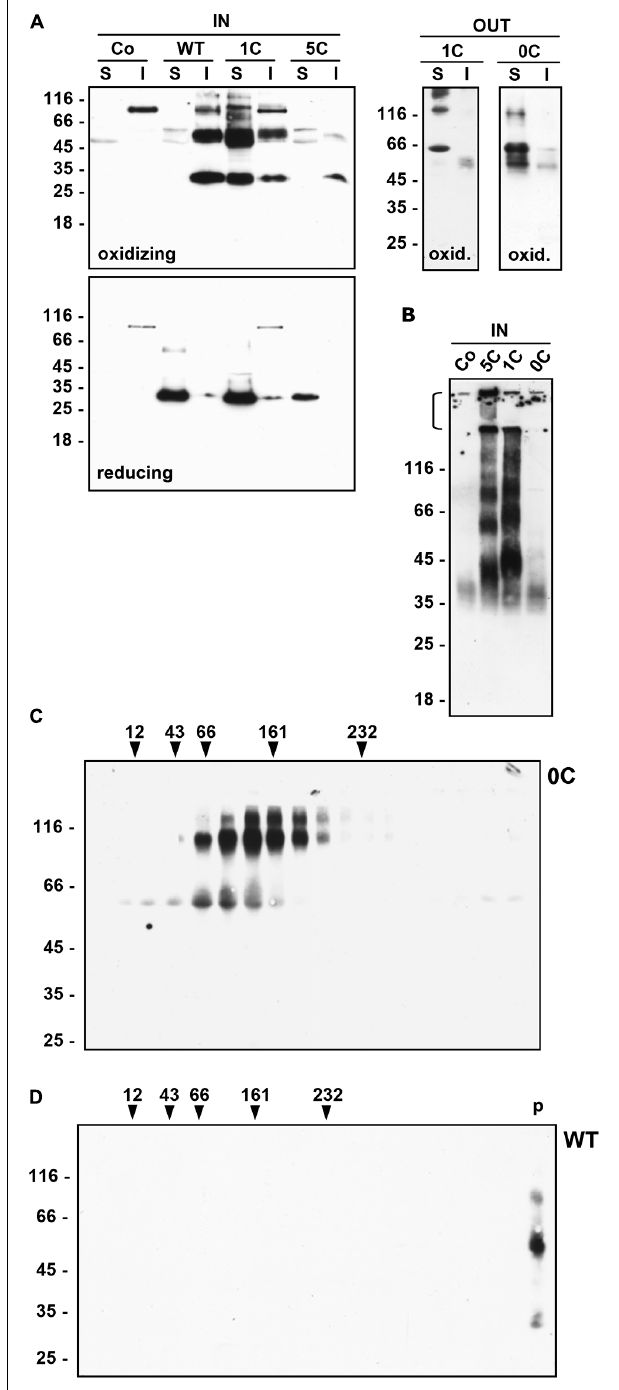
FIGURE 2 | Solubility and assembly of γ -zein constructs. (A) Tobacco protoplasts were transfected with plasmid containing the indicated γ -zein constructs or with empty plasmid as control (Co) and incubated for 24 h. Protoplasts (IN) or incubation medium (OUT) were homogenated in the presence (reducing) or absence (oxidizing) of 2ME. After centrifugation, soluble (S) and insoluble (I) proteins were analyzed by SDS-PAGE in reducing conditions and protein blot with anti-flag antiserum. (B) Protoplasts transfected as in (A) were homogenated in the